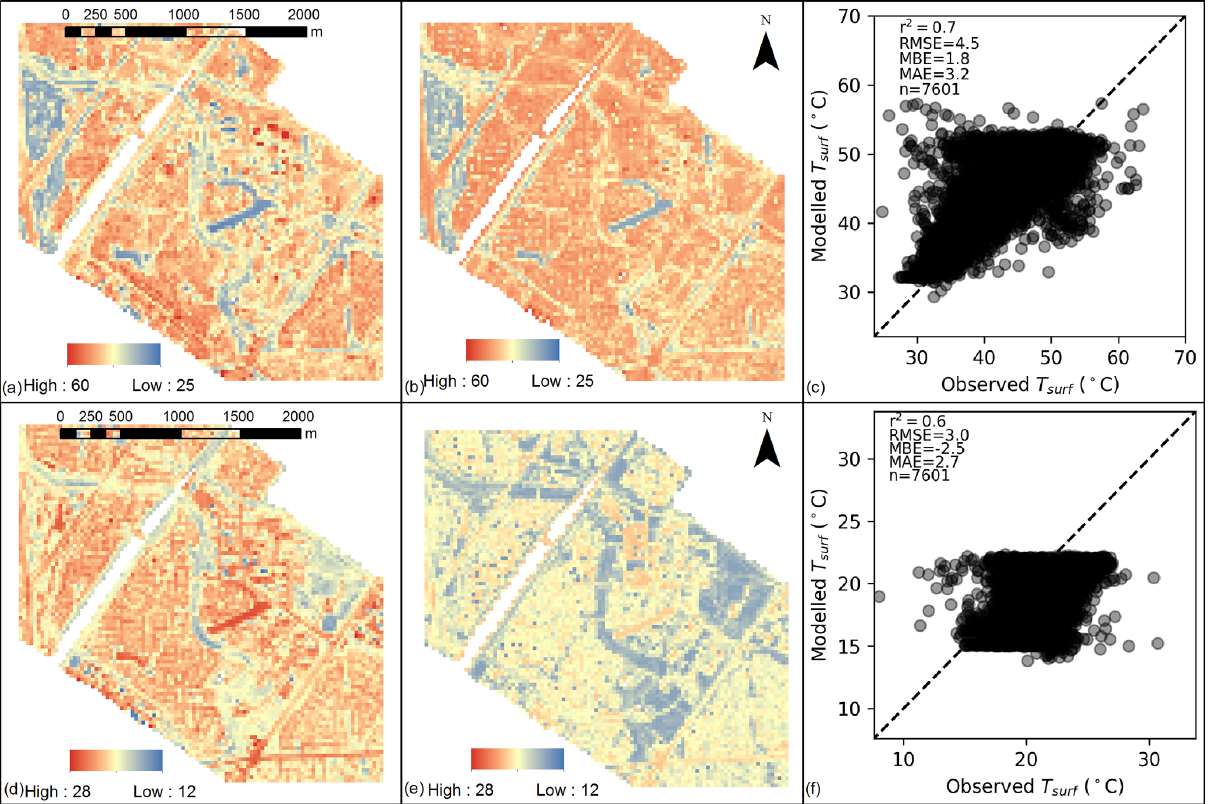
Figure 5. Mawson Lakes observed (a, d) T surf and modelled (b, e) T surf for day (a–c) and night (d–e) . Areas where land cover is categorized as “other” are not simulated. Note that T surf here does not include T surf , wall for comparison with horizontally averaged aerial imagery observations.